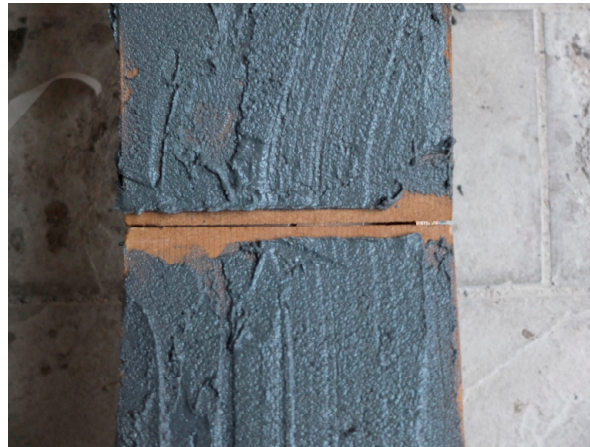
Figure A3. Butyl tape removal.